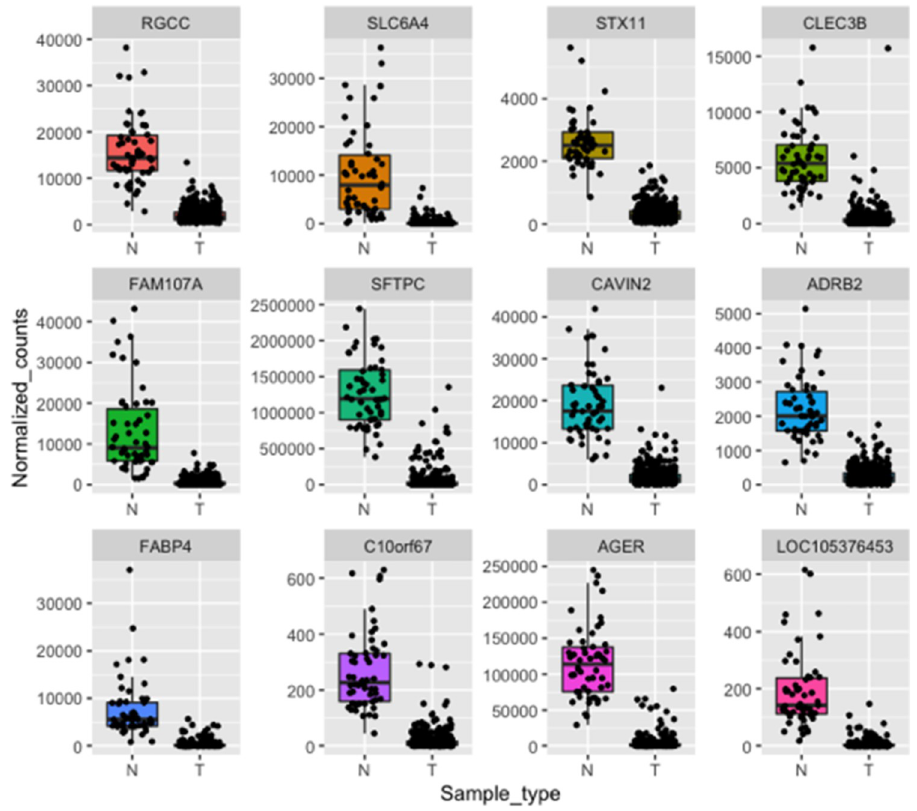
Fig 9. Boxplots representing the expression level of the 12 common candidate genes in LUAD patients in comparison to normal samples. N represents normal tissues and T represents tumor tissues.